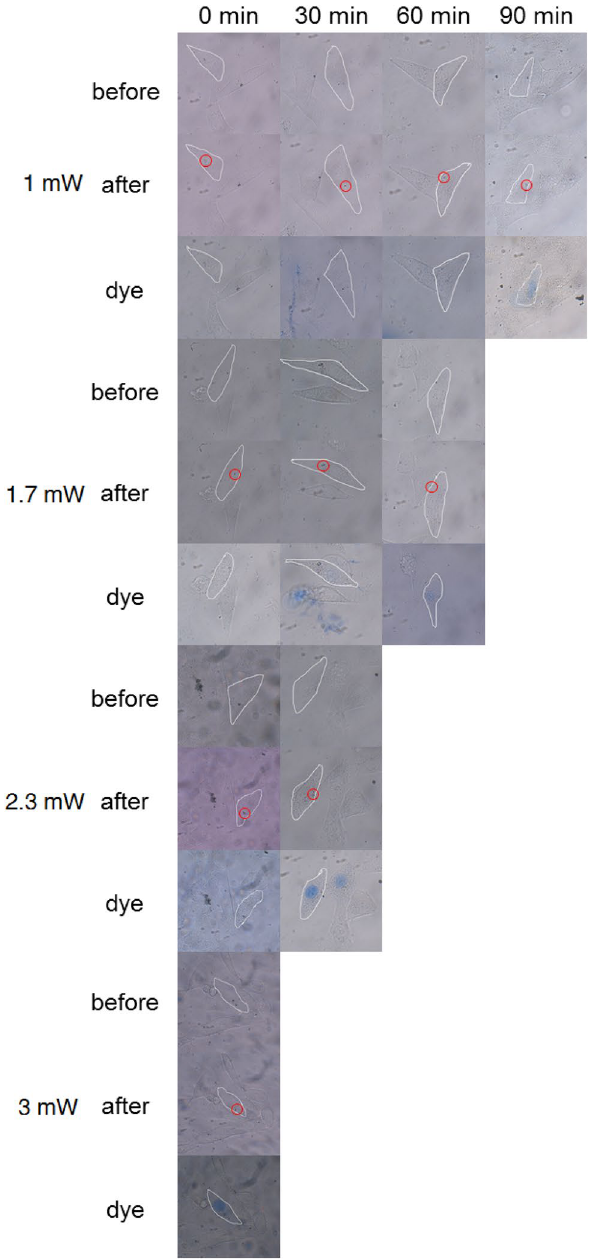
Figure 4. Photothermal treatment of GNBs with an AR of 2.92 under 760 nm fs pulsed laser, the laser focuses on the nano clusters in the cell. The red circle in the figure marks the position of the laser. The selected cell is indicated by white line.